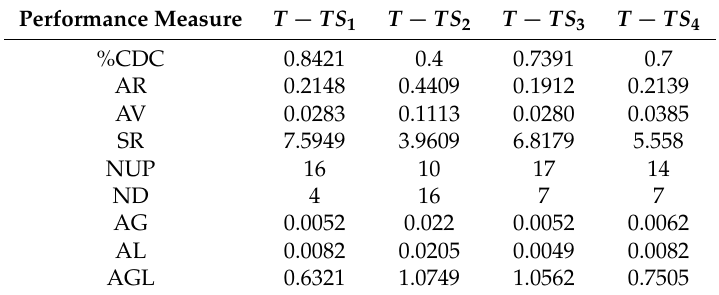
Table 10. Performance values of the trading signals in the test